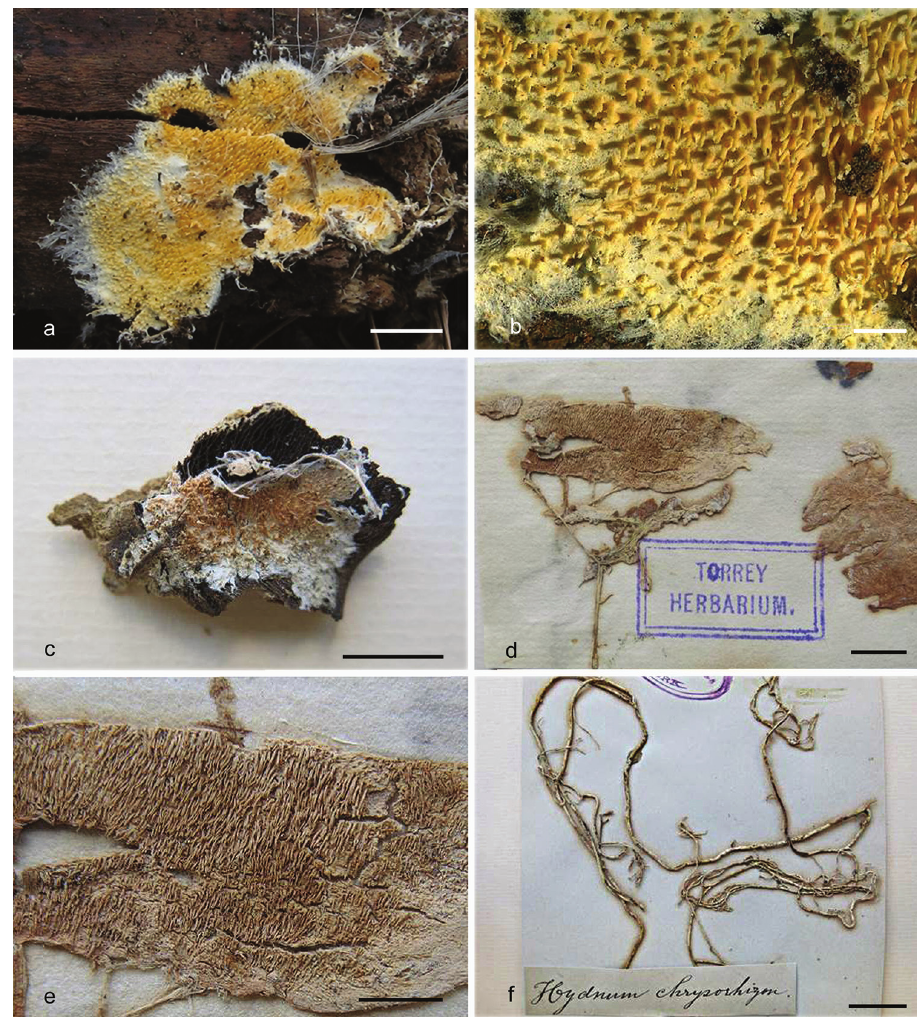
Figure 3. Hydnophlebia canariensis. a , b Collection 17035Tell., MA-Fungi 86622, holotype, basidiome, wet (a) and hymenophore, dry specimen (b) c Collection 17038Tell. MA-Fungi 86623, basidiome, dry specimen. Hydnophlebia chrysorhizon . Collection NY, lectotype d Basidiome, dry specimen e Hymeno- phore, dry specimen f Strands, dry specimen. Scale bars: a, e = 5 mm; b = 1.5 mm; c, d, f = 1